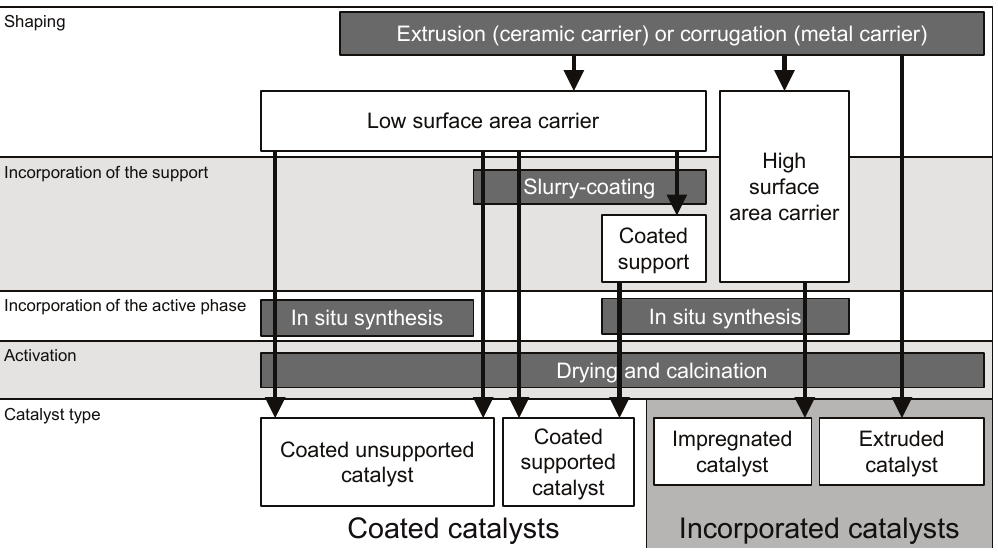
Figure 8. Paths for the preparation of structured perovskite catalysts. Adapted with permission from a more general scheme by Avila et al. [85]. Copyright 2005,